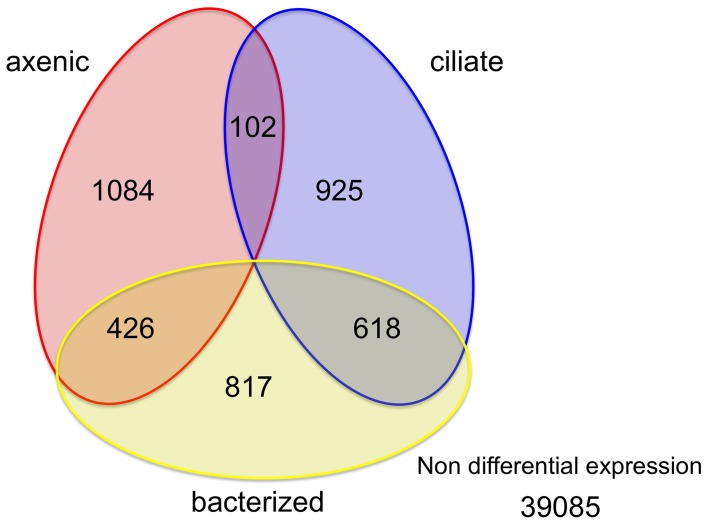
Distribution of genes according to changes in their expression levels among three treatments. Numbers in each area indicate numbers of genes whose expression levels were higher in that treatment compared to the other two or in two treatments compared to the third.